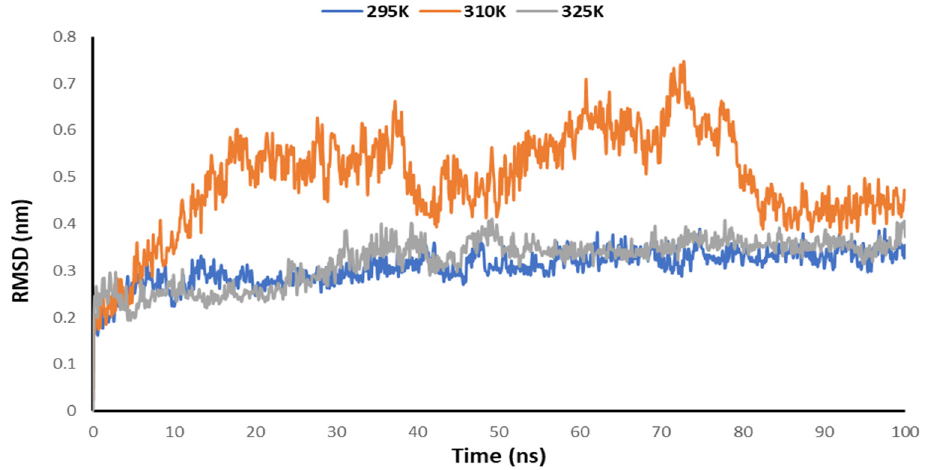
Figure 8. Trajectory of RMSD for the main protease of SARS-CoV-2 with 2DG at 295, 310 and 315 K.